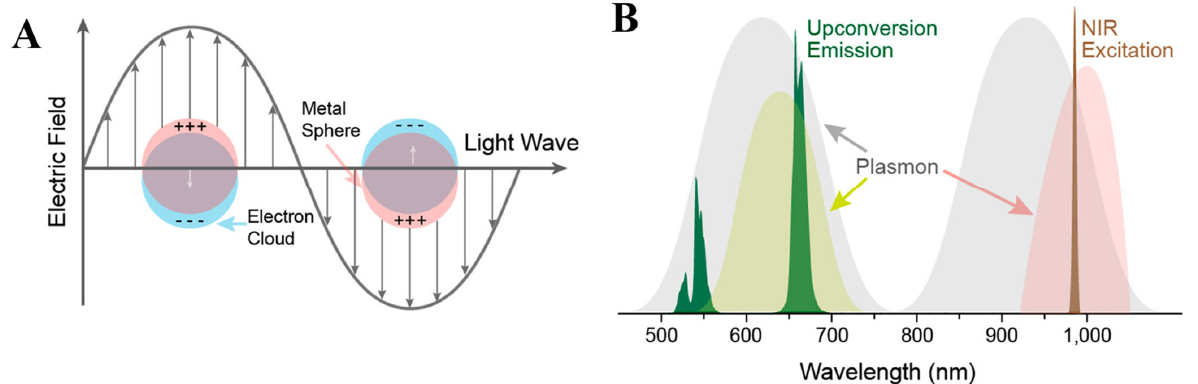
Figure 2. ( A ) Schematics of a metal nanoparticle’s electron cloud oscillation. ( B ) Spectral overlap between metal nanoparticle’s SPR and upconversion nanoparticles emission or excitation profile. Reprinted with permission from reference